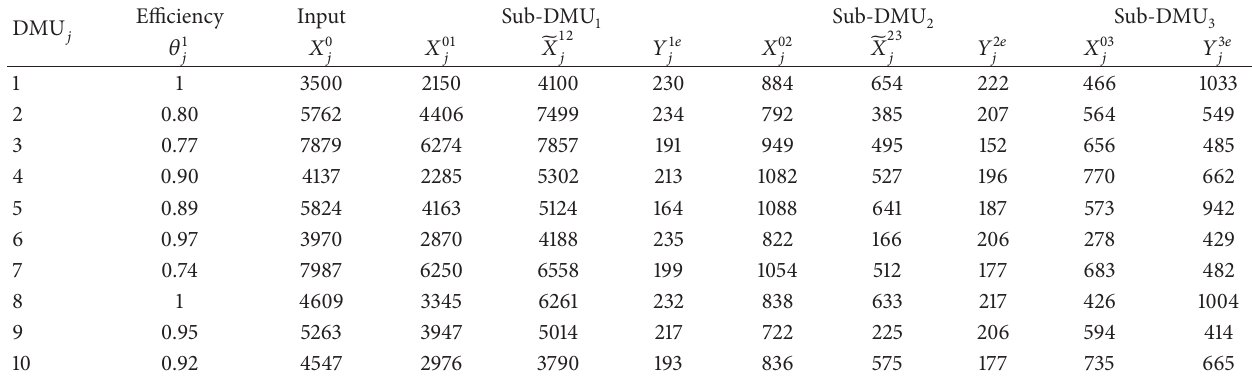
Table 3: Evaluation data of DN-DEA ( 𝑡 = 3